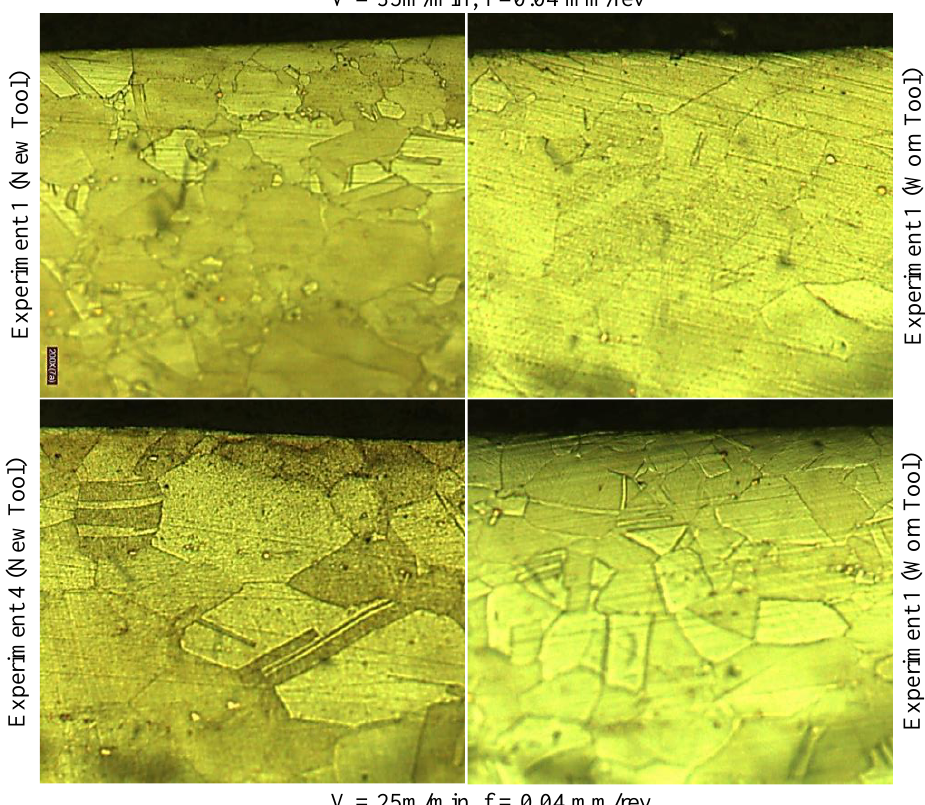
Figure 22. Microstructure images of the cross-section beneath the hole surface.